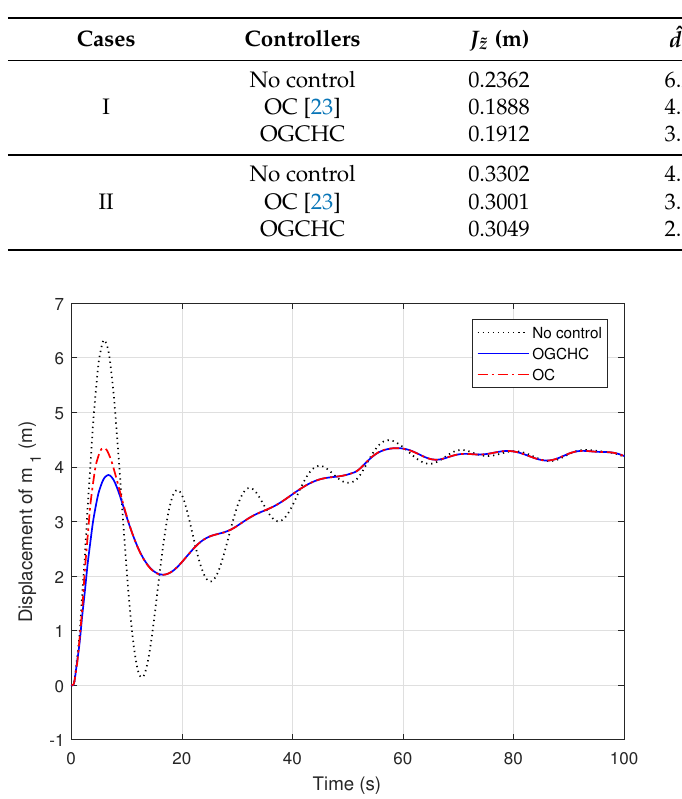
Figure 3. Displacement 1 of the riser without control, with OC and OGCHC under case I.